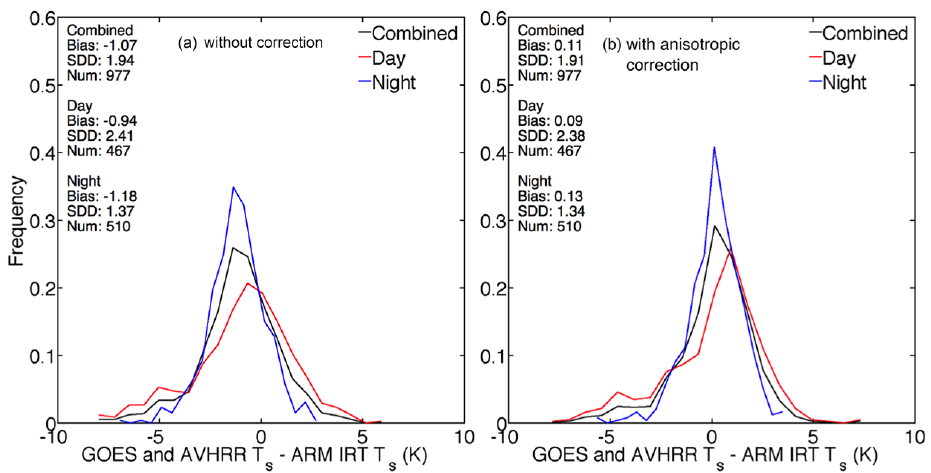
Figure 12. Probability distributions of LST differences between satellite (GOES-13, GOES-15, and AVHRR) and ARM IRT (a) without and (b) with anisotropic correction.